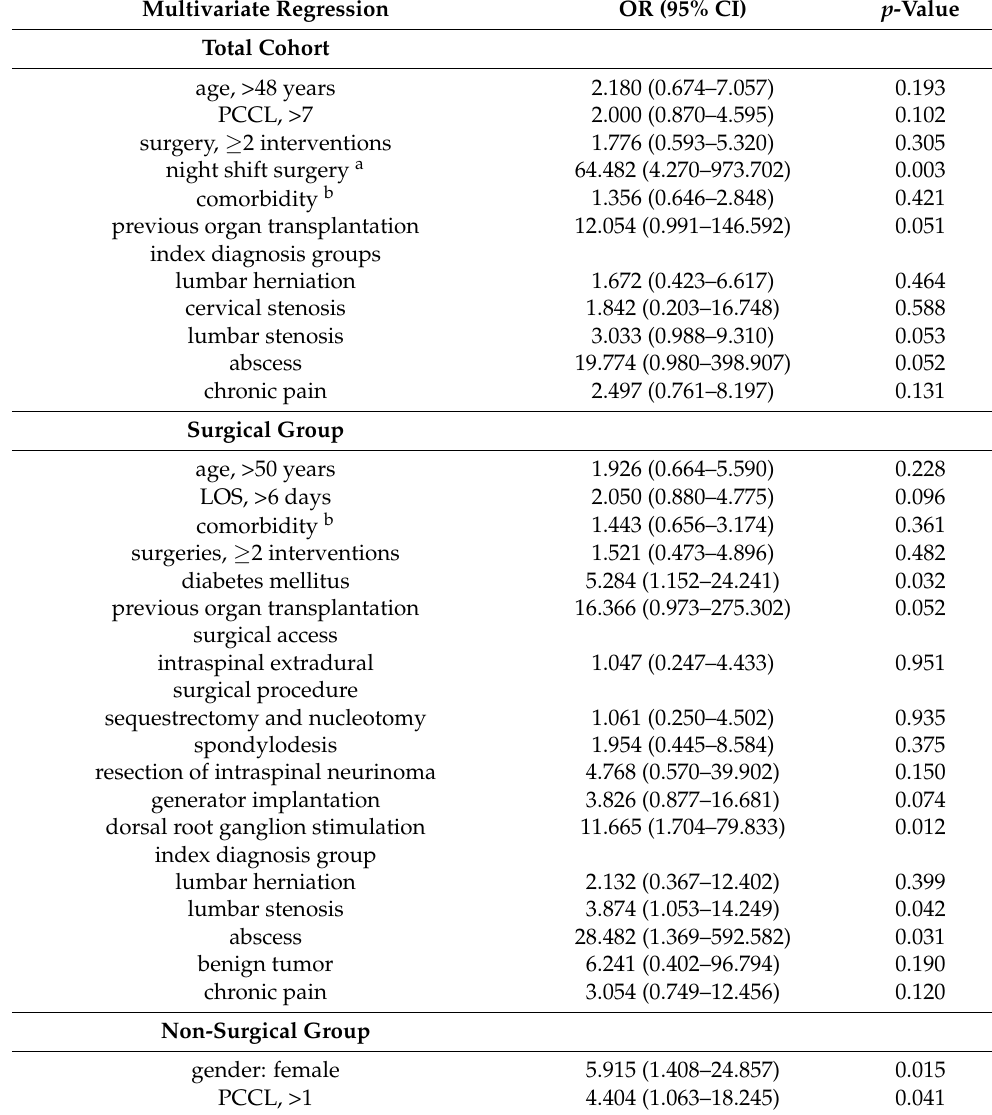
Table 5. Predictors for unplanned readmission. Multivariate logistic regression for demographic data and hospital characteristics. Factors at the univariate level with a p -value ≤ 0.20 were integrated into the multivariate logistic regression